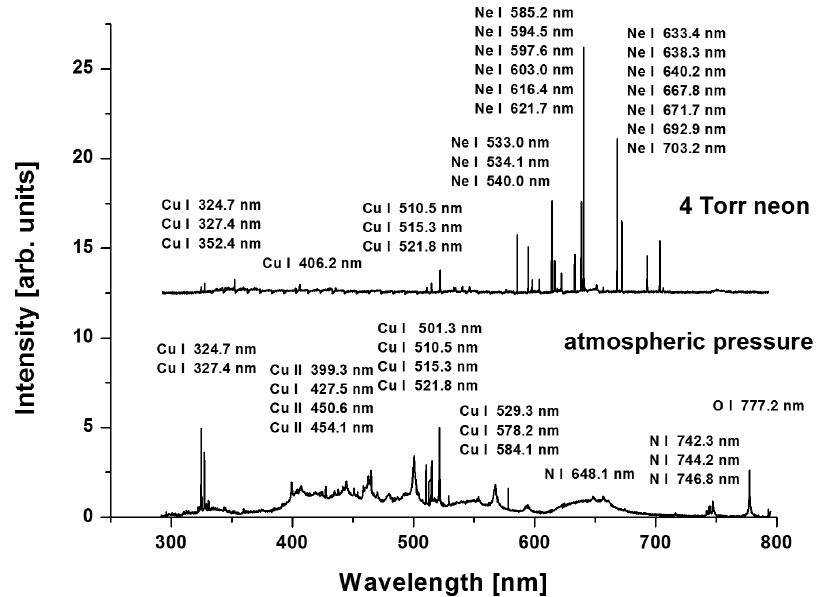
Figure 2 : Laser-induced copper plasma spectra in air at atmospheric pressure (below) and at 4 Torr neon (above) at laser pulse energy 30